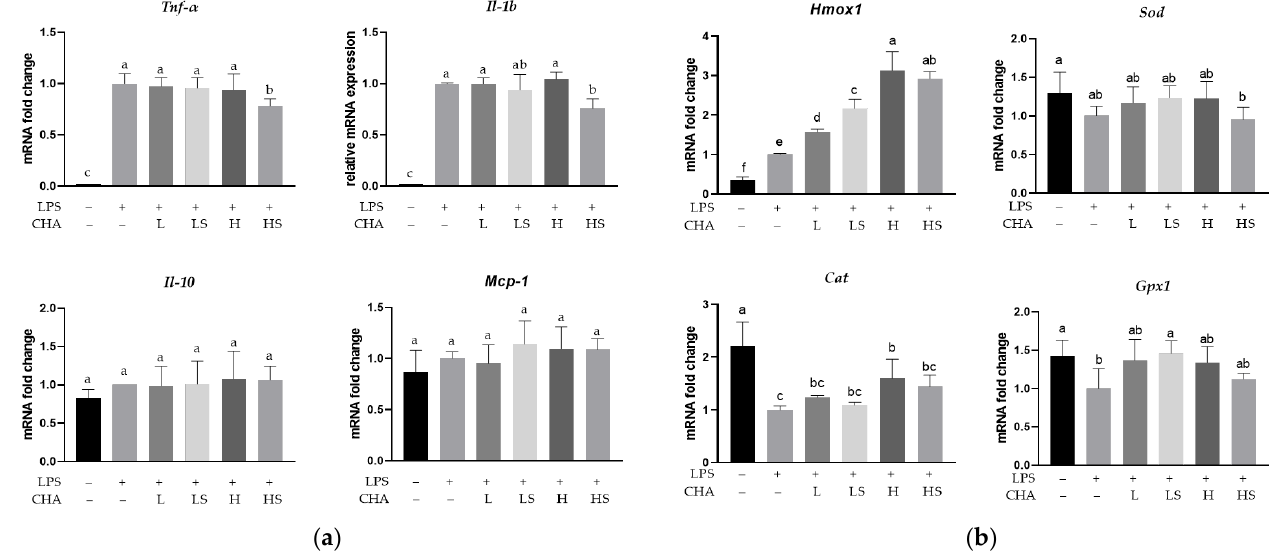
Figure 4. Effect of different delivery models on mRNA expression of pro-inflammatory cytokines and antioxidant genes. Cells were treated with LPS (100 ng/mL) and CHA for 6 h. ( a ) mRNA levels of Tnf- α , Il-1 β , Il-10 , and Mcp-1 were determined 6 h after treatment. ( b ) mRNA levels of Hmox-1 , Sod , Cat, and Gpx-1 were determined 6 h after treatment. Bars without a common letter indicate significant differences ( p < 0.05). CHA: chlorogenic acid; LPS: lipopolysaccharide; TNF: tumor necrosis factor; IL: interleukin; Hmox: Heme oxygenase; Sod: superoxide dismutase; Mcp: monocyte chemoattractant protein; Cat: catalase; Gpx: glutathione peroxidase; L: low dose administered via pipette; LS: low dose administered via syringe pump; H: high dose administered via pipette; HS: fmapk.